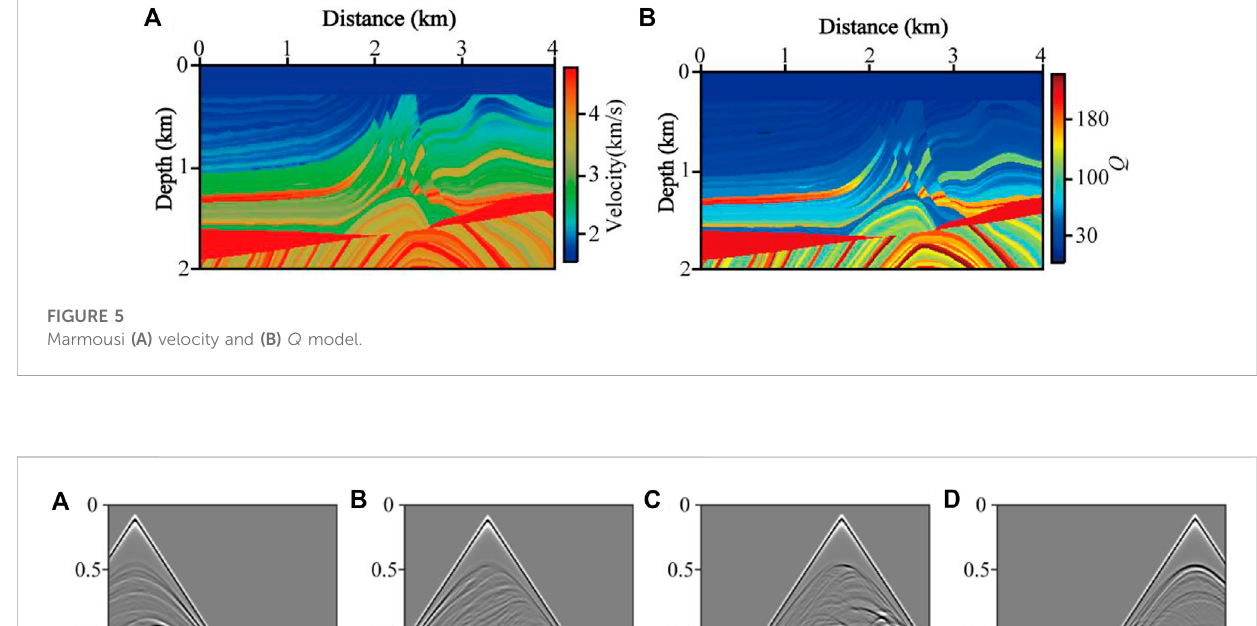
Frontiers in Earth